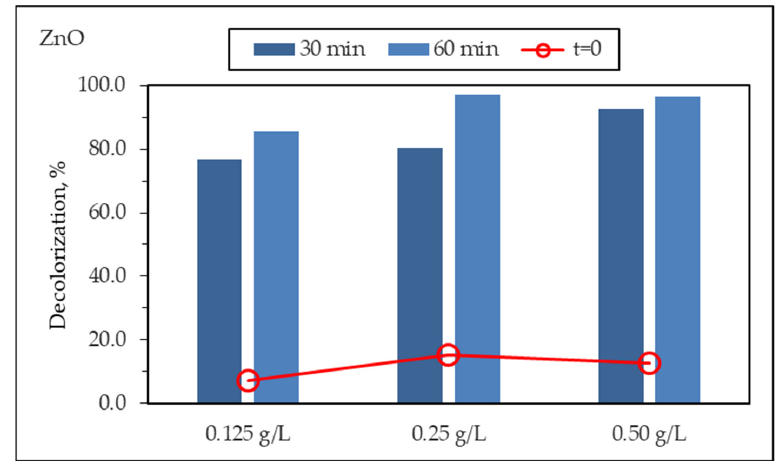
Figure 10. Photocatalytic degradation of MB upon use of sole ZnO: Dose effect.